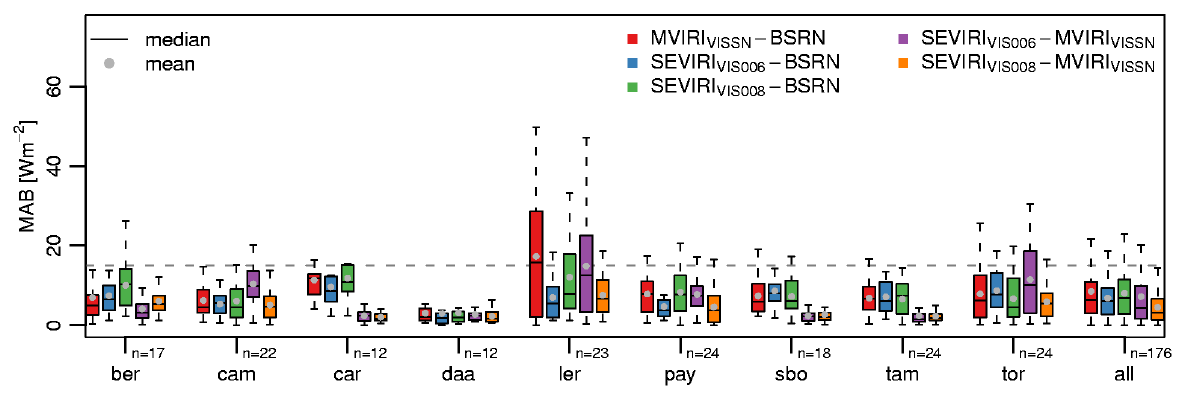
Figure 4. Comparison of satellite retrieved SIS versus BSRN measurements for 4 selected